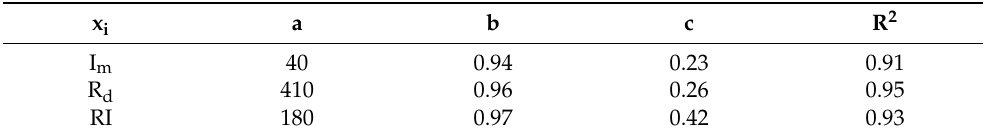
Table 1. Empirical coefficients a, b, and c for the rainfall indices: maximum hourly rainfall depth (I m ), maximum 24-h rainfall amount (R d ), and RI (I m × R d ). x i a b c R